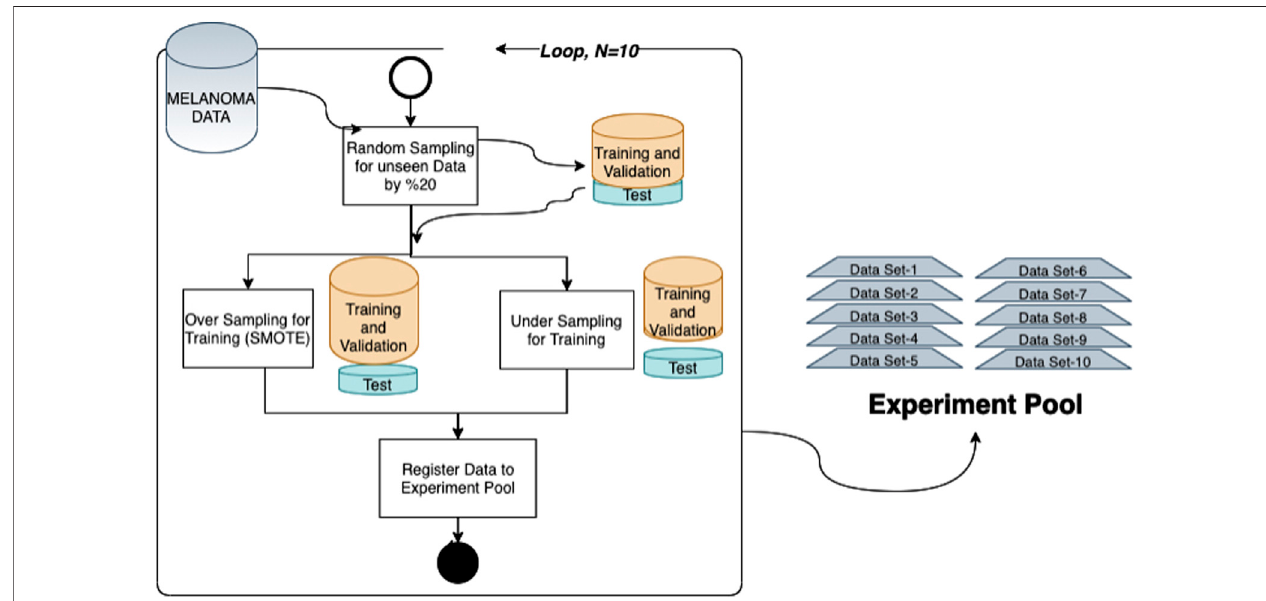
FIGURE 2 | Training validation and unseen test data generation in each trial; for this purpose, the following steps are followed for both undersampling and oversampling.1)Thesigni fi cantvariableslistedinthegivencategoryareselectedfromthedataset.2)Asetselectedrandomlyfromwholedatawithan80%ratioofeach class is kept for unseen data. 3) A technique is applied to solve the curse of the dimensionality problem (for dimensional reduction, principal component analysis is applied, and for oversampling runs, the SMOTE algorithm is used with K (cid:1) 3). 4) Steps 1 – 3 are repeated for each data split in the experiment